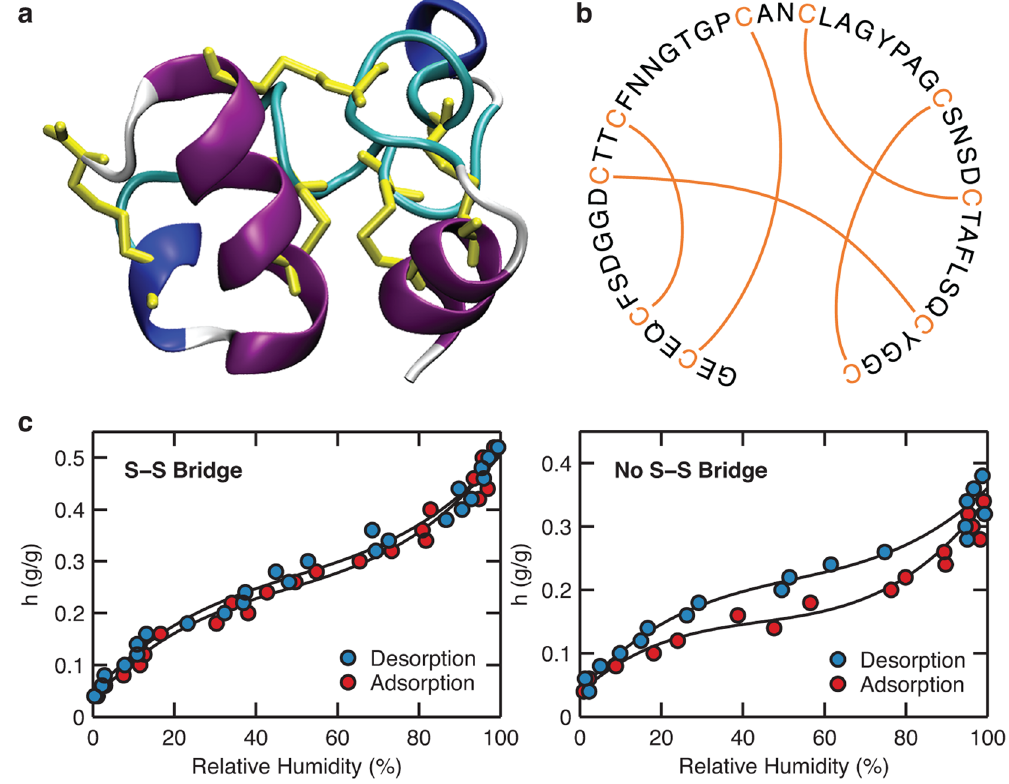
Figure 1. Visualizations of the ( a ) three-dimensional structure and ( b ) sequence of pheromone ER-23. There are five disulfide bridges, shown explicitly by yellow bonds ( a ) and orange lines ( b ). ( c ) Water sorption isotherms of pheromone ER-23 with (left) and without (right) disulfide bridges. Black lines are drawn as a guide to the